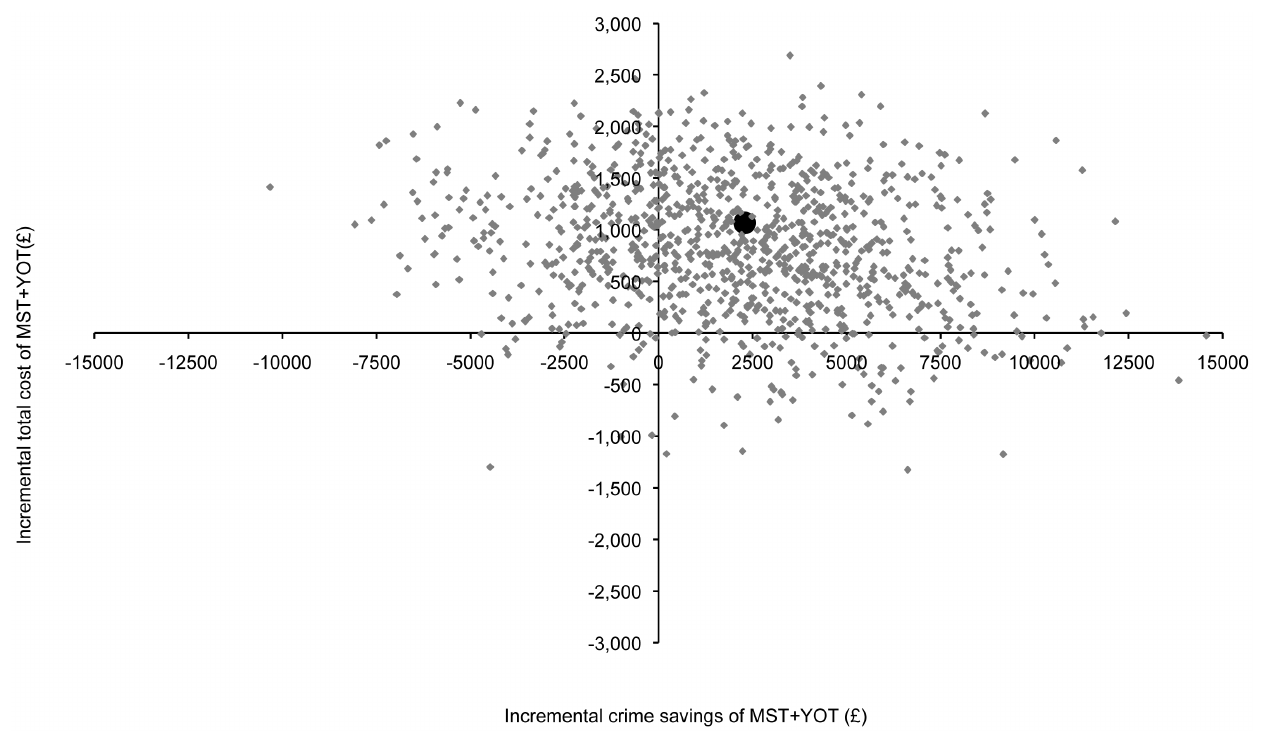
Figure 1. Bootstrapped incremental costs and incremental crime savings of MST + YOT versus YOT.